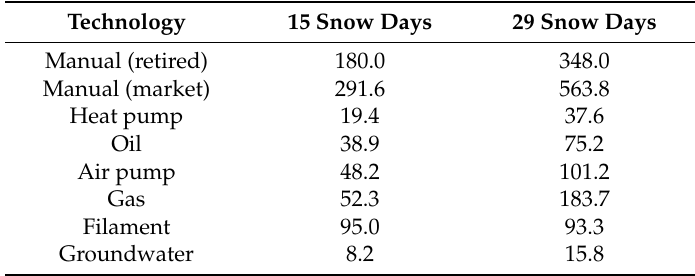
Table 1. Estimated annual costs of differing snow-melting technologies (million JPY/year).